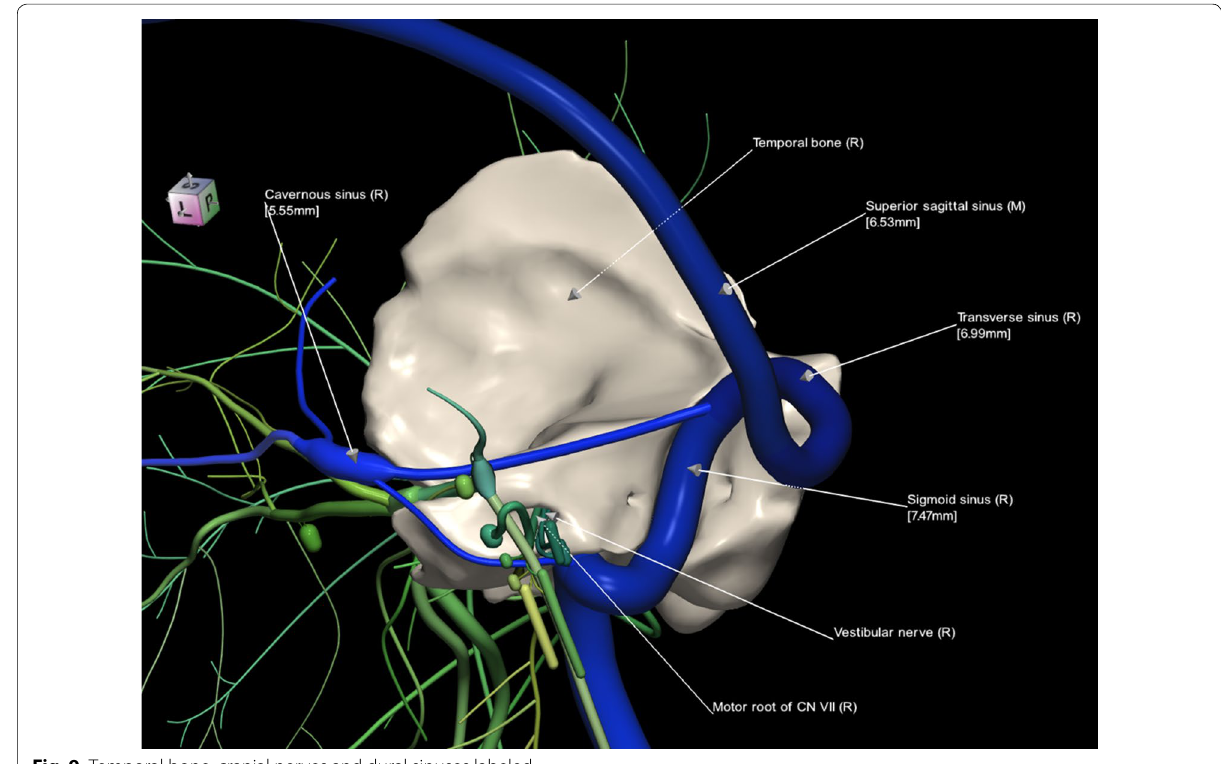
Fig. 9 Temporal bone, cranial nerves and dural sinuses